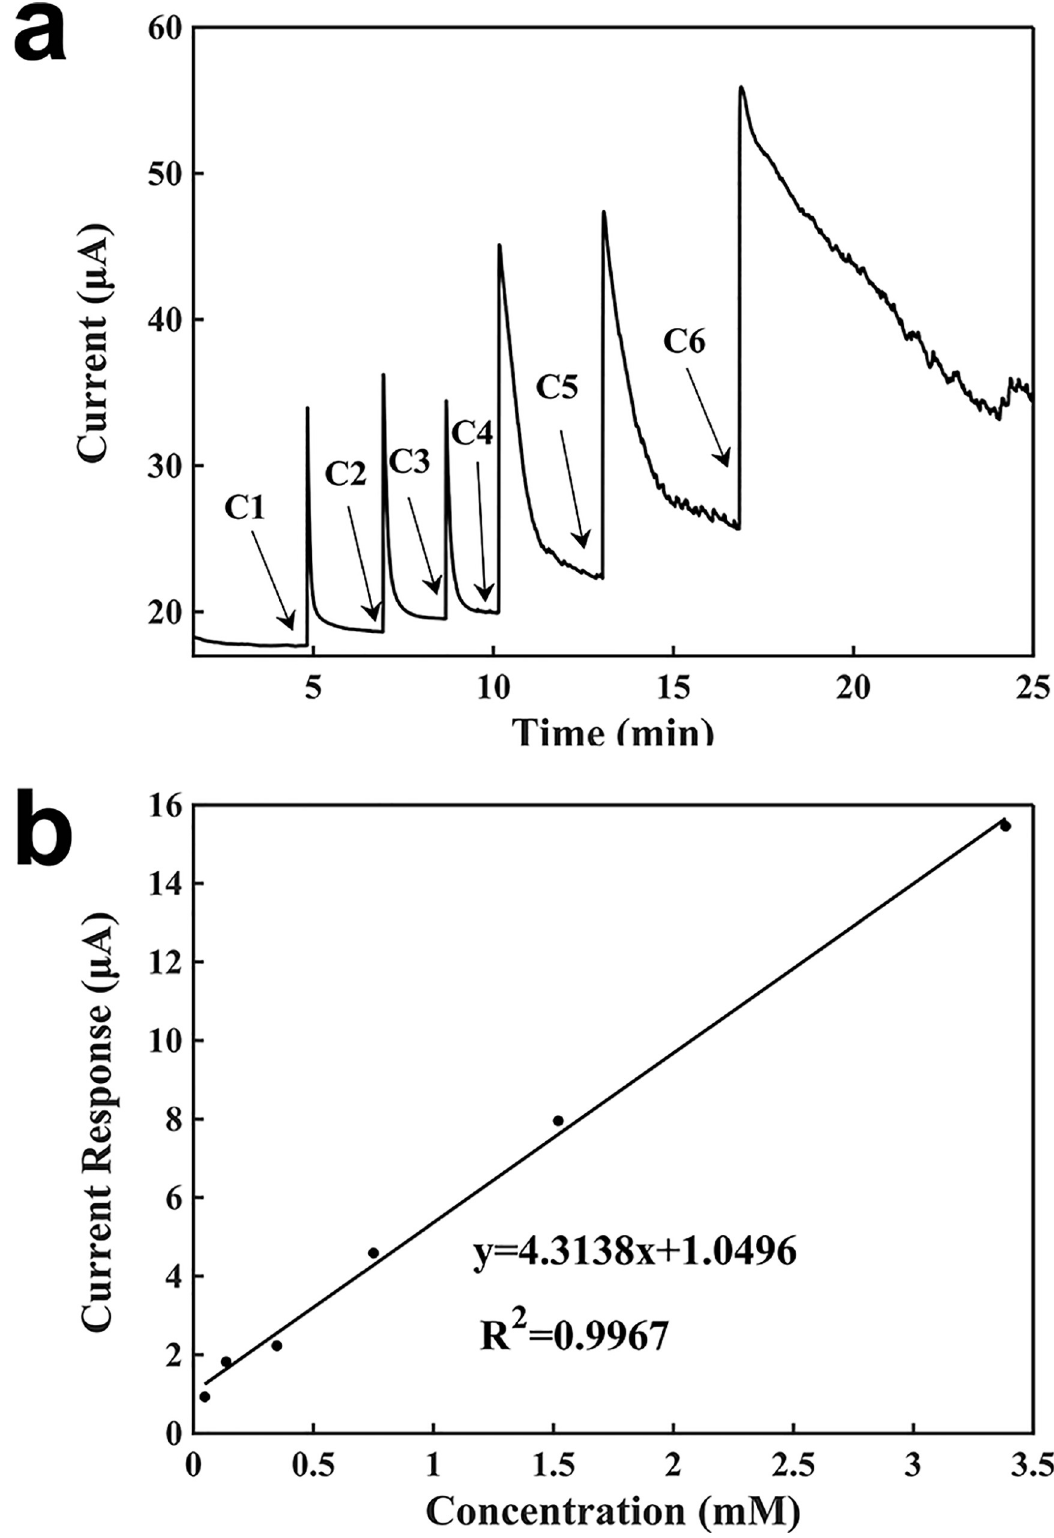
Fig 5. Characterization of the sensor for the detection of H 2 O 2 with a battery. (a) Current-verses-time response curve upon the additions of H 2 O 2 . C1: 0.04762 mM, C2: 0.08875 mM, C3: 0.21146 mM, C4: 0.40217 mM, C5: 0.77000 mM, C6: 1.86462 mM. (b) Calibration curve for the detection of H 2 O 2 .